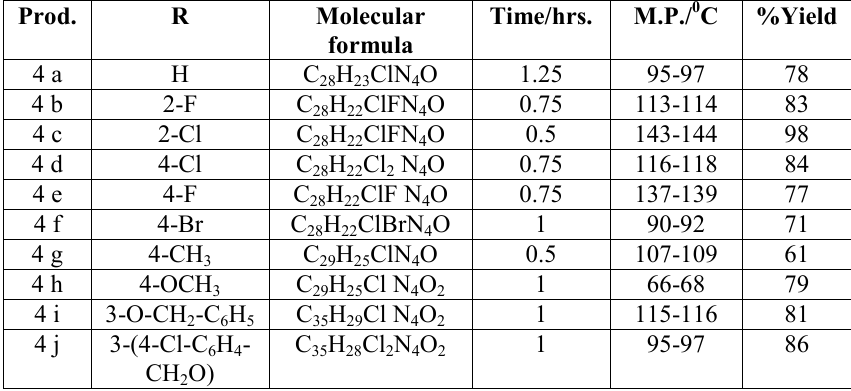
Table 2. Reaction times, melting points and yields for the prepared pyrazolines (4a-j). Prod. R Molecular formula